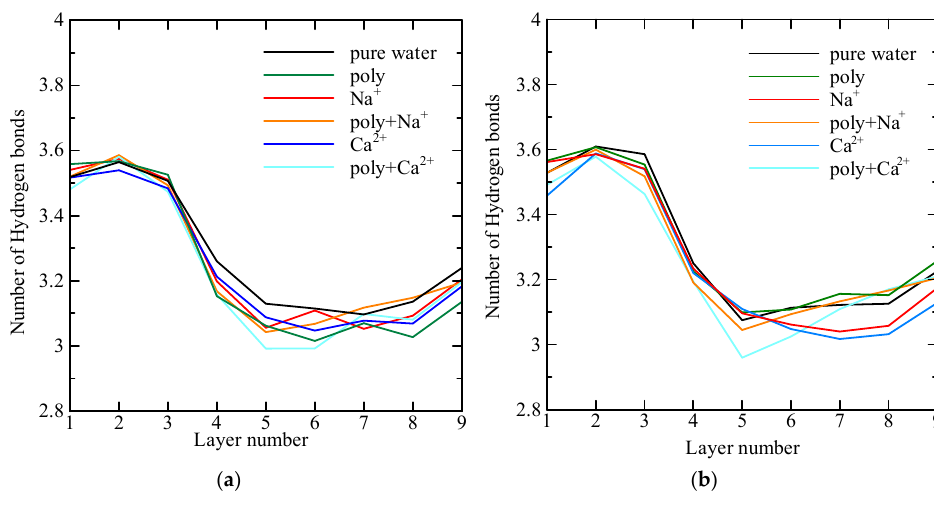
Figure 5. Number of hydrogen bonds in the layers; ( a ) for 1000–1050 ps, ( b ) for 1950–2000 ps.